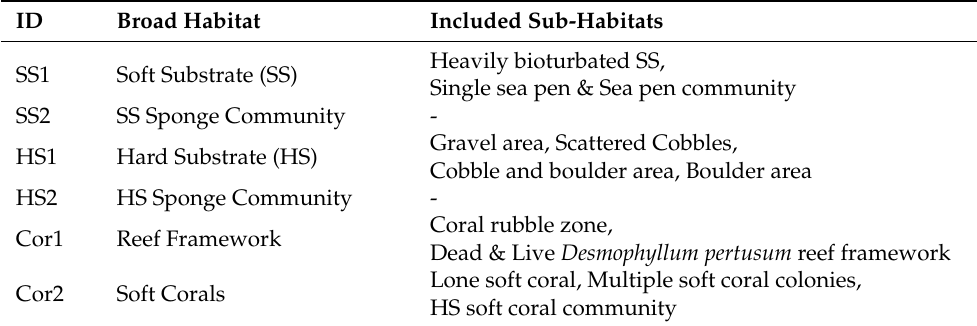
Table 1. Habitat classes encountered within the image